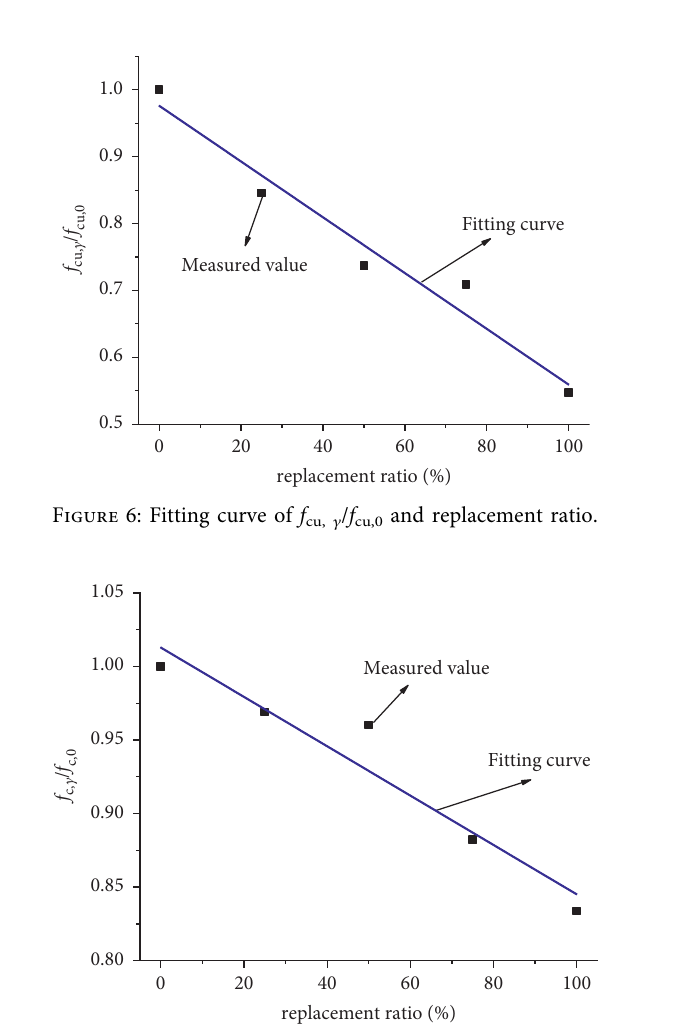
Figure 7: Fitting curve of f c, c / f c,0 and replacement